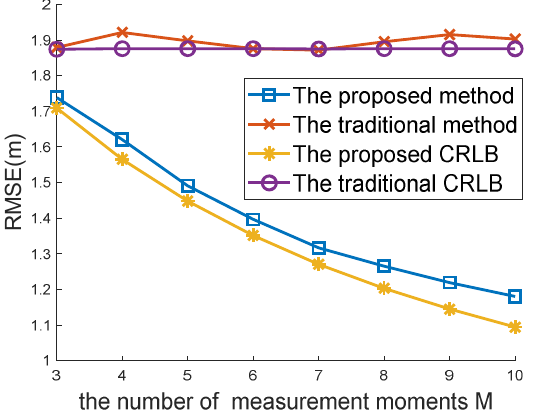
Figure 5. Comparison between the traditional method and the proposed method under different